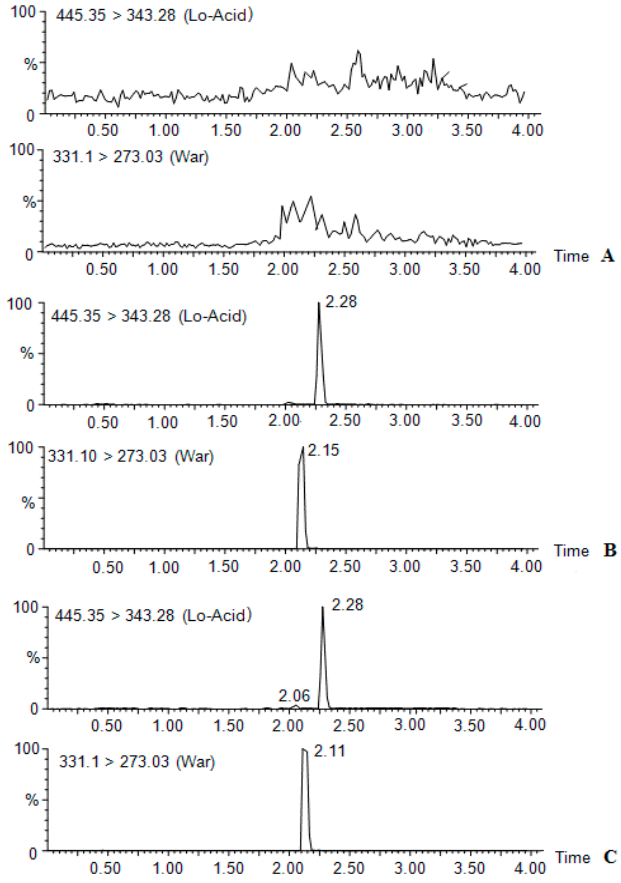
Figure 2. The chromatography for specification of lovastatin acid in rat plasma. ( A – C ) are the representation of the rat blank plasma, the reference spiked into blank plasma (1.0 ng·mL − 1 ) and the true plasma samples at 1 h. Table 2. UPLC-MS/MS method validation data for the determination of lovastatin acid in rat plasma ( n = 6).